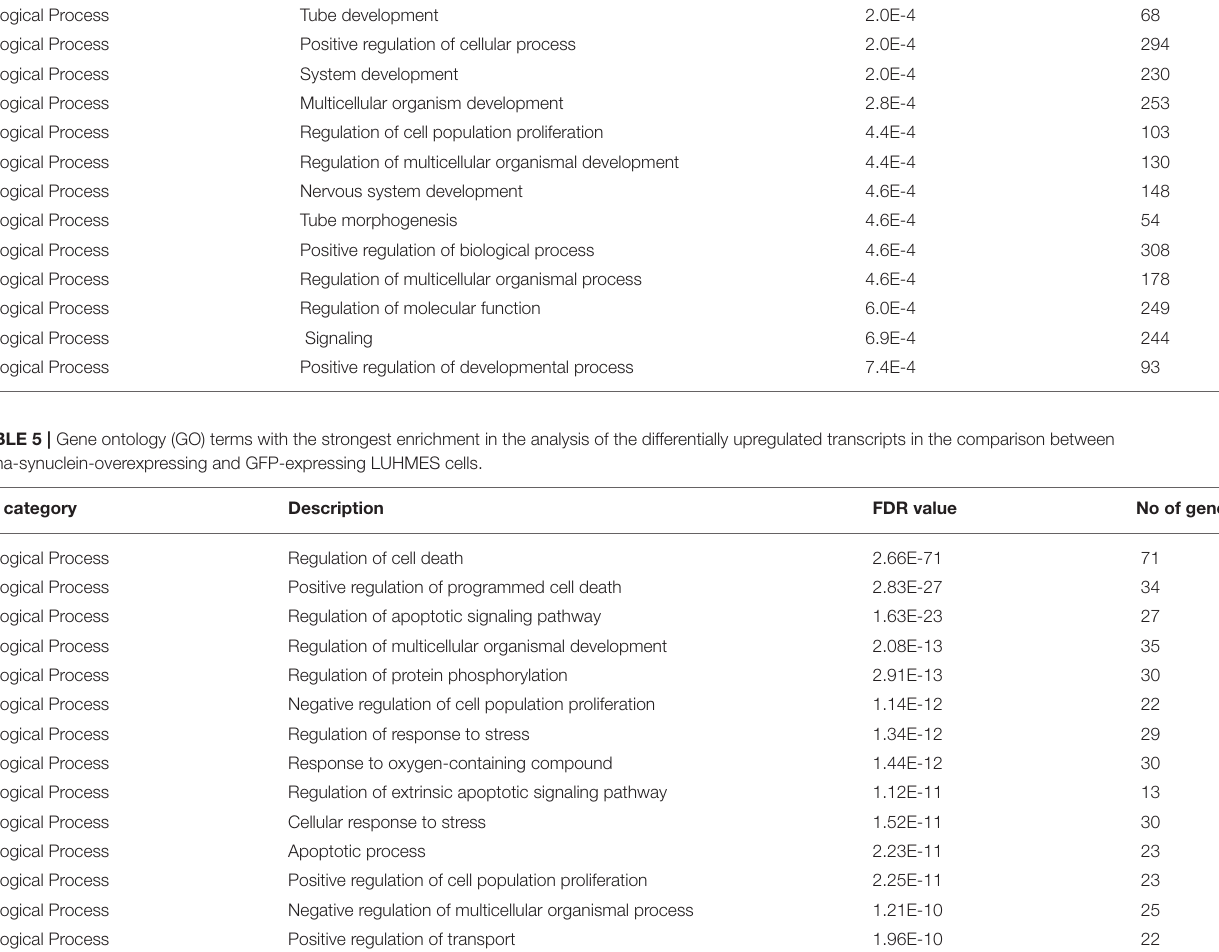
FIGURE 3 | (C) MTHFD2, methylenetetrahydrofolate dehydrogenase (NADP + dependent) 2, methenyltetrahydrofolate; (D) SHMT2, serine hydroxymethyltransferase 2; (E) WARS1, tryptophanyl-tRNA synthetase 1; (F) PSAT1, phosphoserine aminotransferase 1; (G) TFRC, transferrin receptor; (H) SERPINB6, serpin Family B, Member 6; (I) ASNS, asparagine synthetase (glutamine-hydrolyzing); (J) ARHGEF2, Rho/Rac guanine nucleotide exchange Factor 2; (K) SLC7A1, solute carrier Family 7, Member 1; (L) EDF1, endothelial differentiation-related Factor 1; (M) SCARB2, scavenger receptor Class B, Member 2; (N) CNTN2, contactin 2; (O) MDGA1, MAM domain containing glycosylphosphatidylinositol Anchor 1; (P) NCALD, neurocalcin delta; (Q) ADD1, Adducin 1; (R) STXBP1, syntaxin-binding Protein 1; (S) ALDH6A1, aldehyde dehydrogenase 6 Family, Member A1; (T) : LHX9, LIM Homeobox 9; (U) DLG4, discs large MAGUK scaffold Protein 4. Twenty out of 21 proteins (A–S,U) were differentially regulated between α Syn-overexpressing cells and GFP-expressing cells in the same direction as in the LC-MS investigation and thereby confirming these findings. With the exception of TFRC (G) , ADD1 (Q) , ALDH6A1 (S) , and DLG4 (U) , there was no difference in protein levels between untransduced cells and GFP-expressing cells, suggesting an α Syn-specific effect of the protein regulation. One protein (LHX9, T ) could not be confirmed. * p < 0.05, ** p < 0.01, *** p < 0.001 vs. untransduced cells. § p < 0.05, §§ p < 0.01, §§§ p < 0.001 vs. GFP transduced cells.